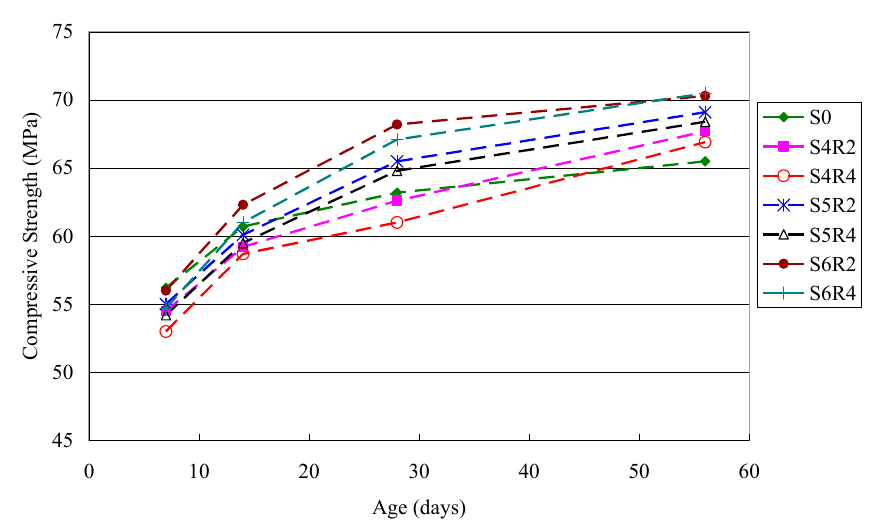
Figure 3. Compressive strength development for cylindrical specimens.